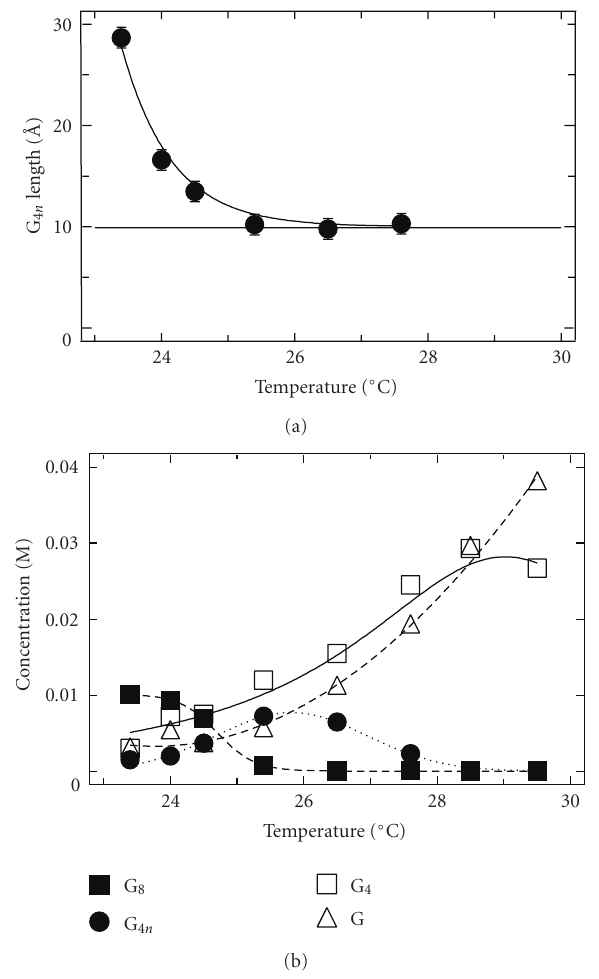
Figure 3: Fitting results. (a) Temperature dependence of the length of G-quadruplexes. (b) Temperature dependence of the concentration of the di ff erent aggregate species. Symbols are as in the text.